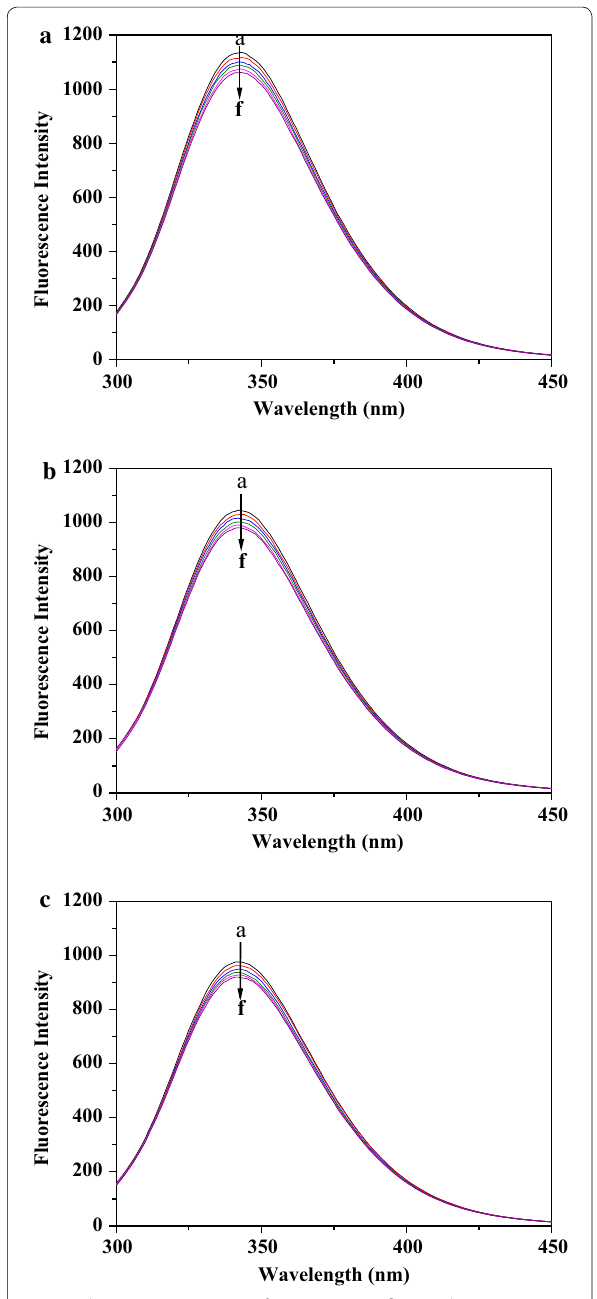
Fig. 2 Fluorescence spectra of HSA tions with paeoniflorin concentrations (a–f) (from 0.0 to 1.25 10 − 5 mol L − 1 at 2.5 × ([HSA] 1.0 10 − 5 mol L − 1 , T = ×